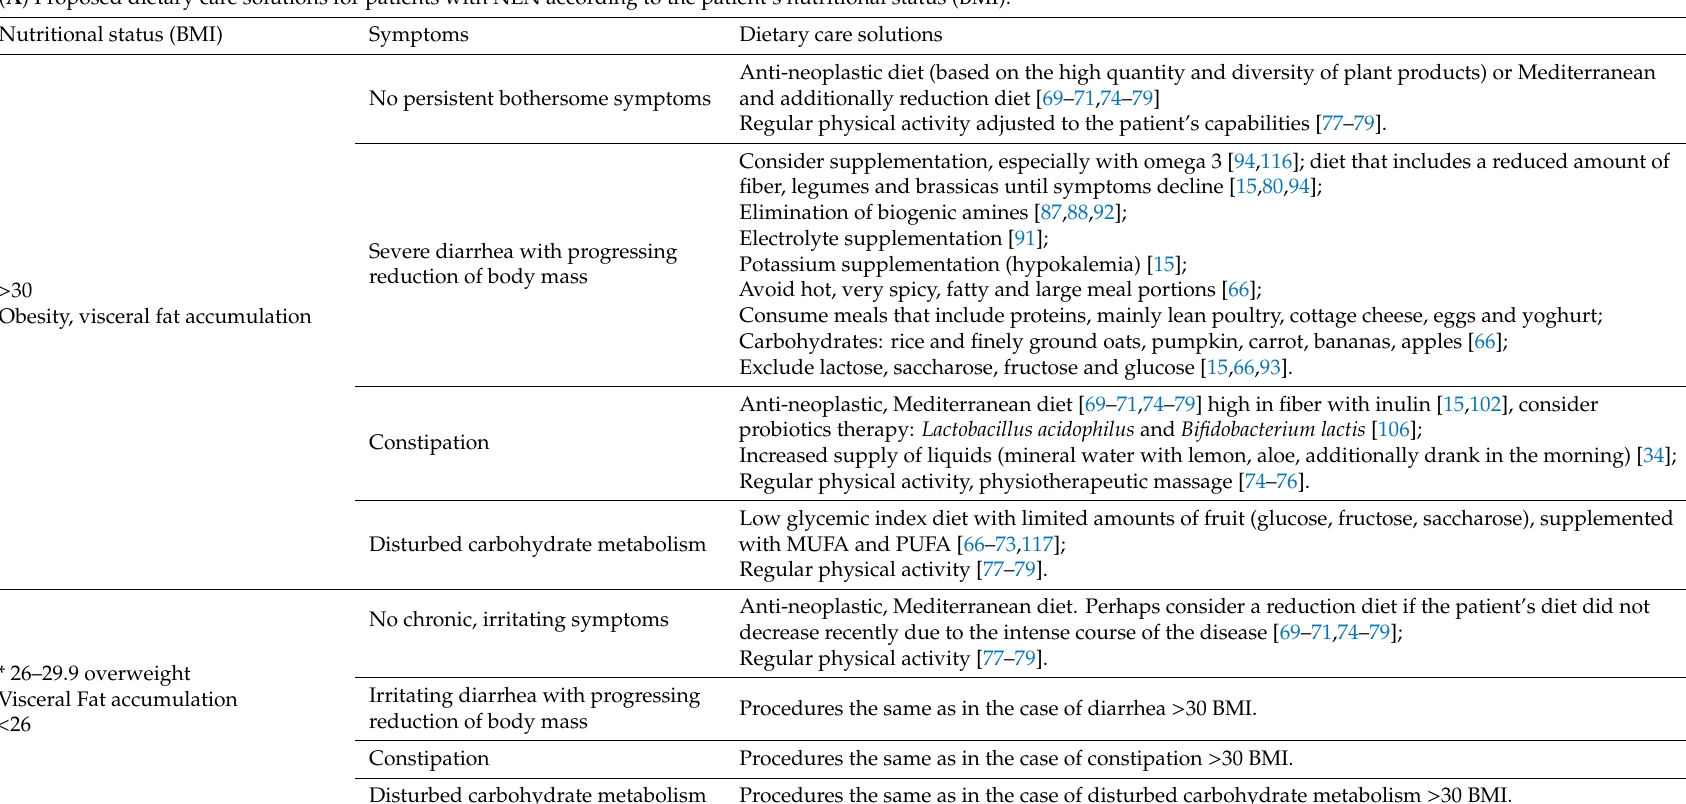
Table 1. ( A ) Proposed dietary care solutions for patients with Nuroendocrine neoplasm (NEN) according to the patient’s nutritional status (BMI). ( B ) Proposed solutions for the dietary care of patients with NEN, taking into account NEN hormone activity. ( C ) Sample pharmacotherapy of NEN patients taking into account interactions with